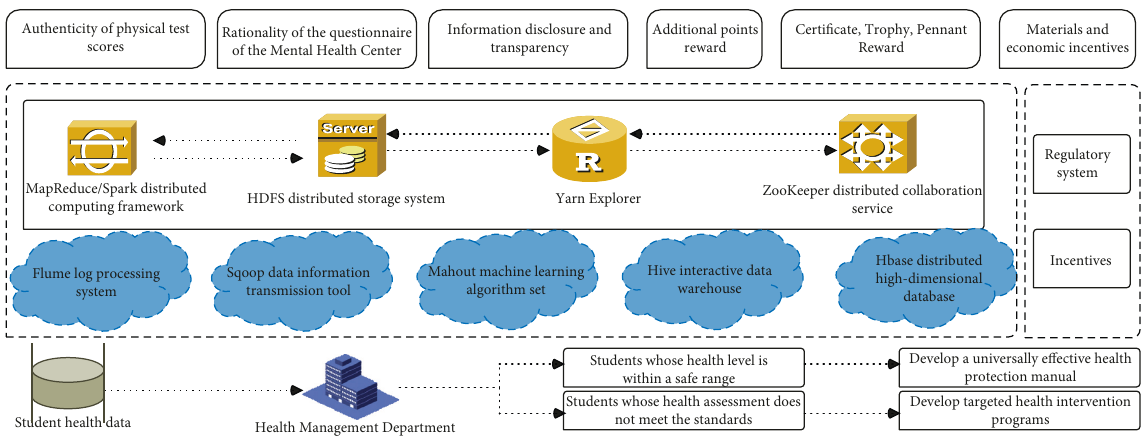
Figure 1: Organizational structure of university student health management service under Hadoop